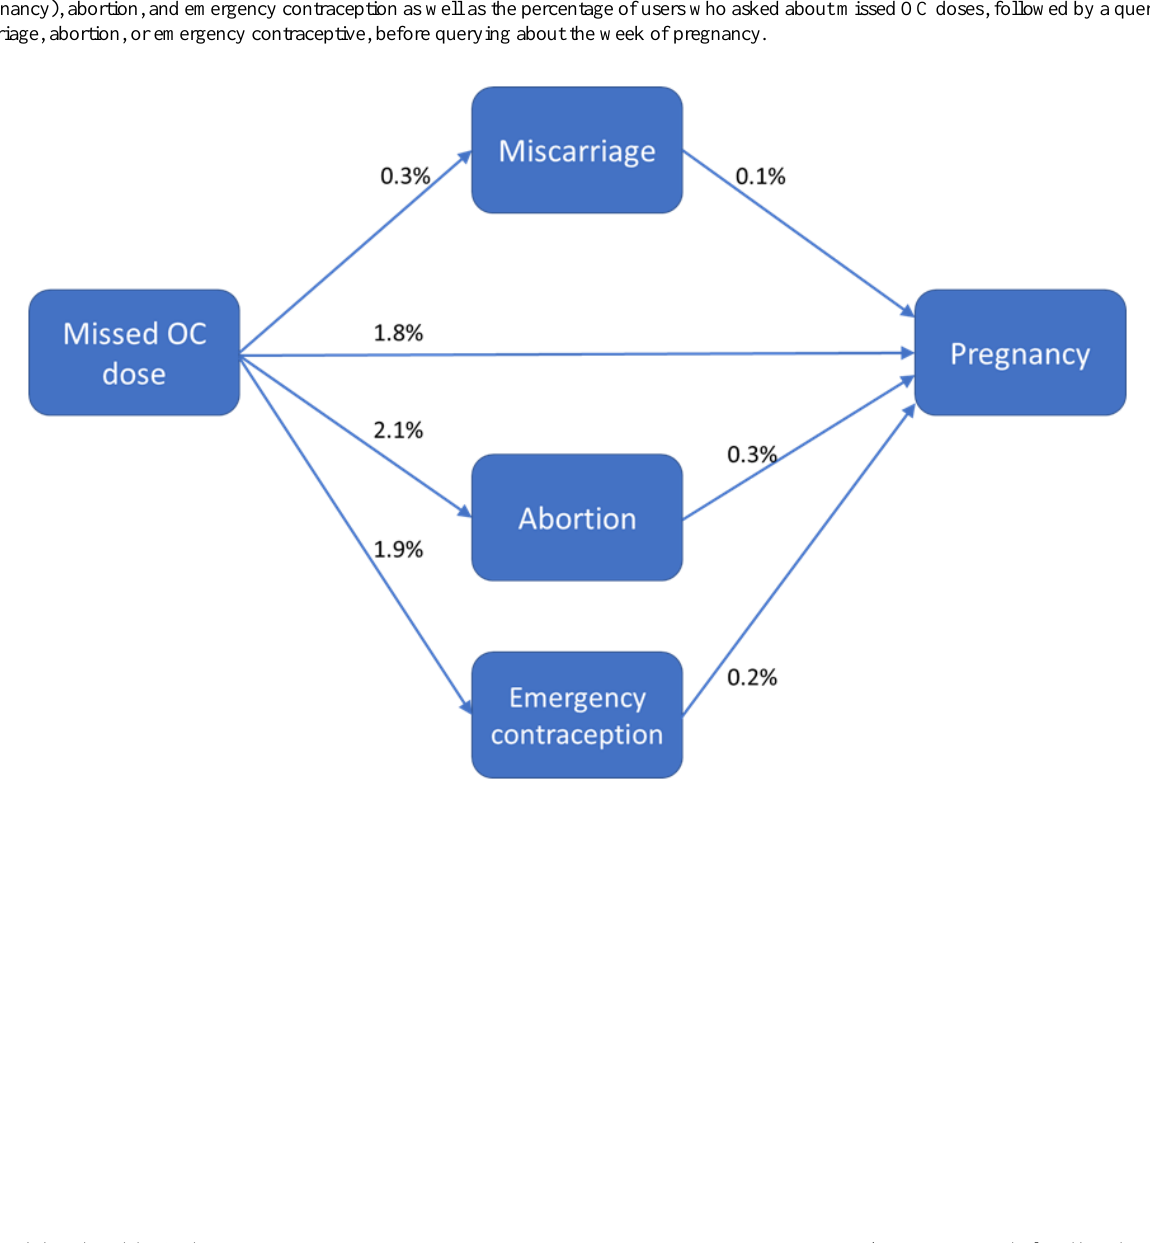
Figure 1. Percentage of users who asked about missed OC doses and then asked about miscarriage, pregnancy (as indicated by a query for the week of pregnancy), abortion, and emergency contraception as well as the percentage of users who asked about missed OC doses, followed by a query about miscarriage, abortion, or emergency contraceptive, before querying about the week of